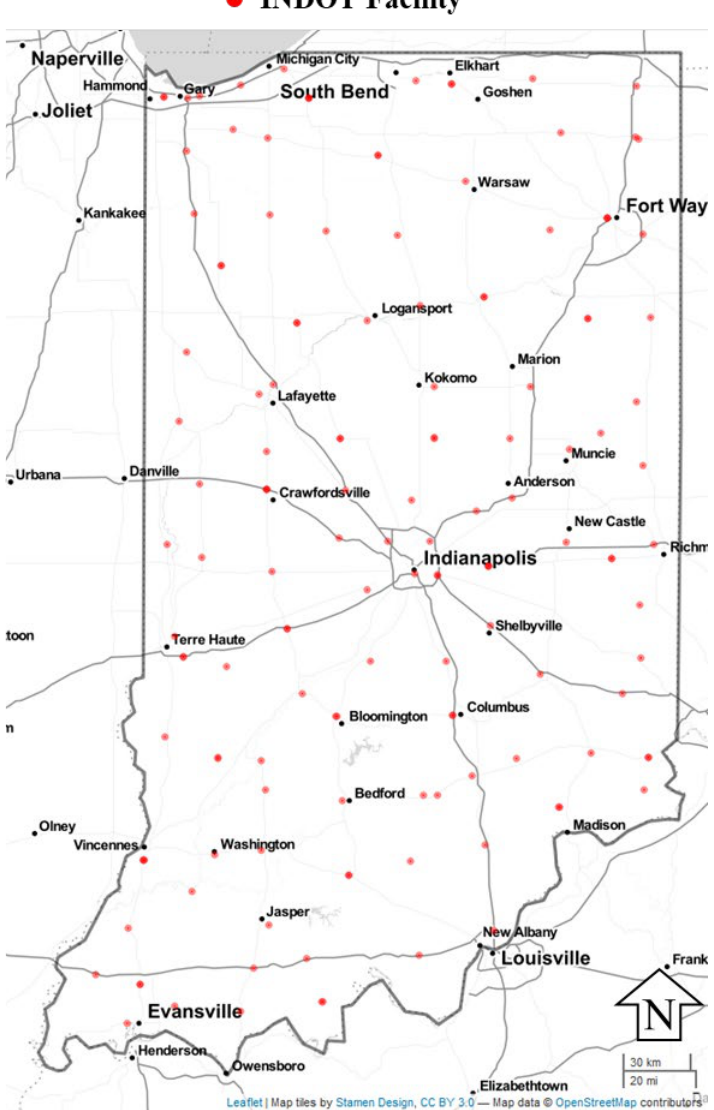
Figure 1. INDOT salt storage facilities and maintenance units.